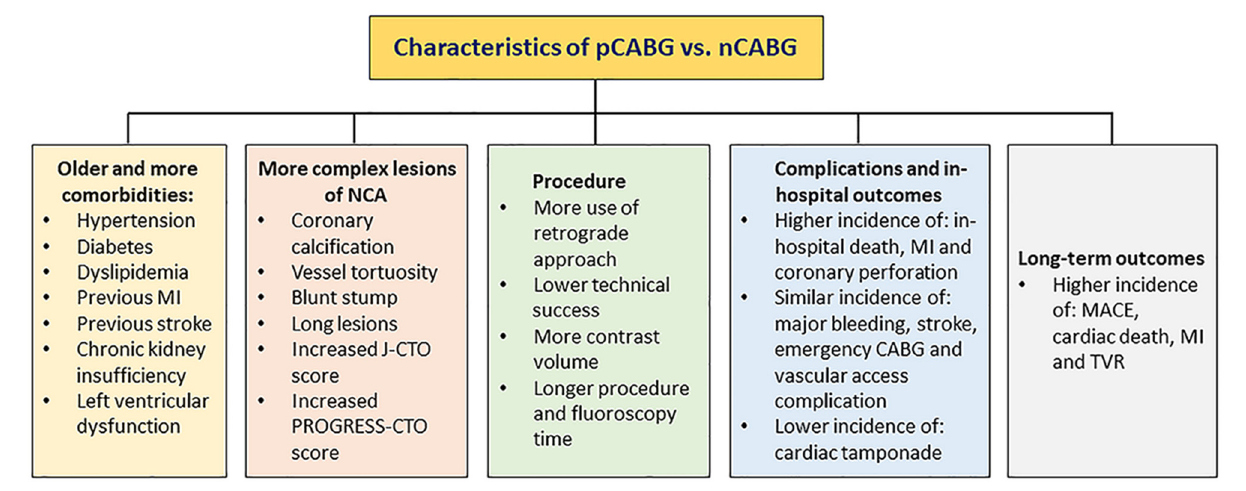
FIGURE 2 | Characteristics of pCABG vs. nCABG. CABG, coronary artery bypass grafting; nCABG, no-CABG; pCABG,